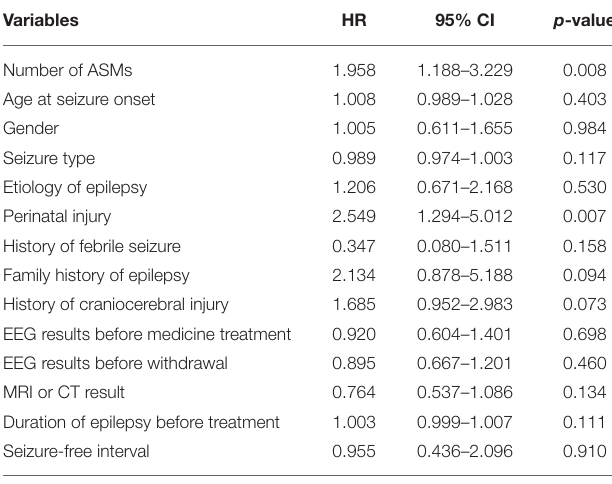
TABLE 3 | Effect of various factors on seizure relapse: multivariate Cox regression analysis. Variables